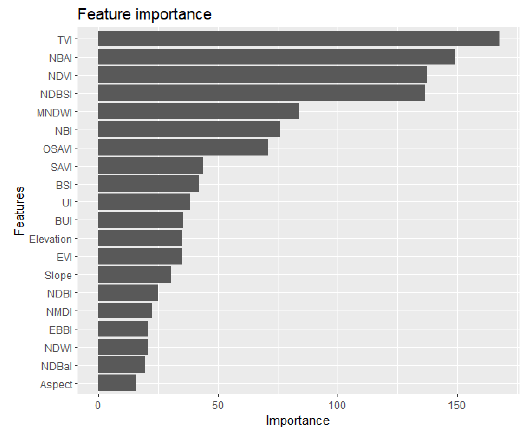
Figure 5 . Feature importance ranking